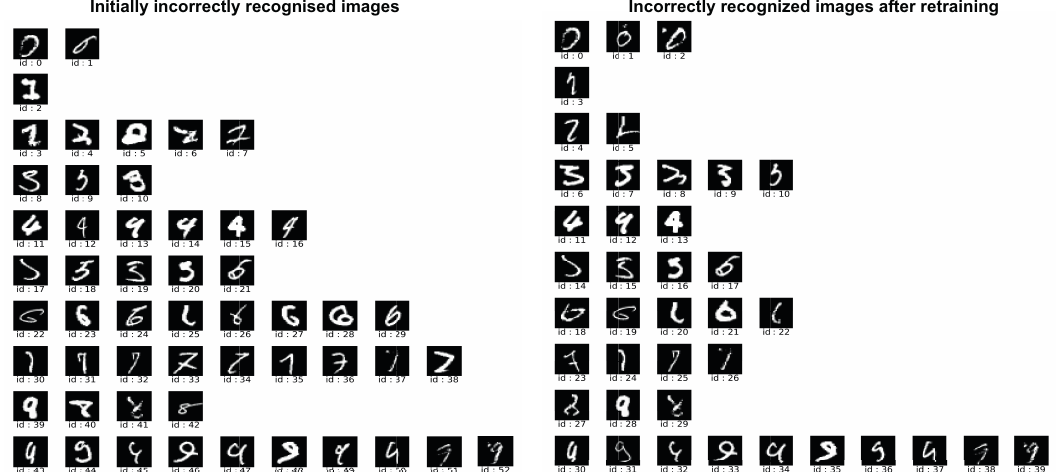
Figure 9. Incorrectly recognized test images after initial and second training.